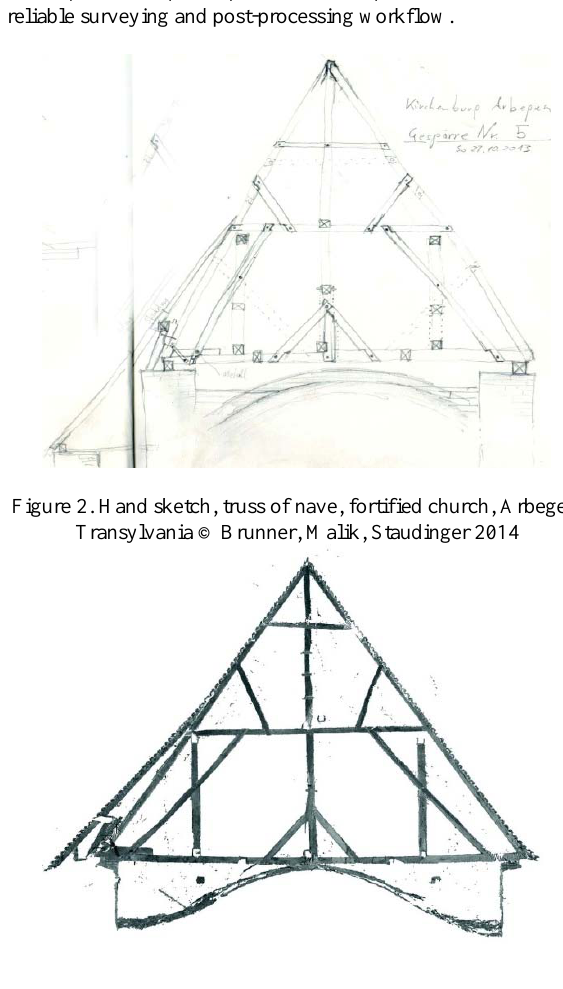
Figure 3. Ortho-projection of point cloud of a principal rafter truss, truss of nave, fortified church, Arbegen, Transylvania © Brunner, Malik, Staudinger 2014